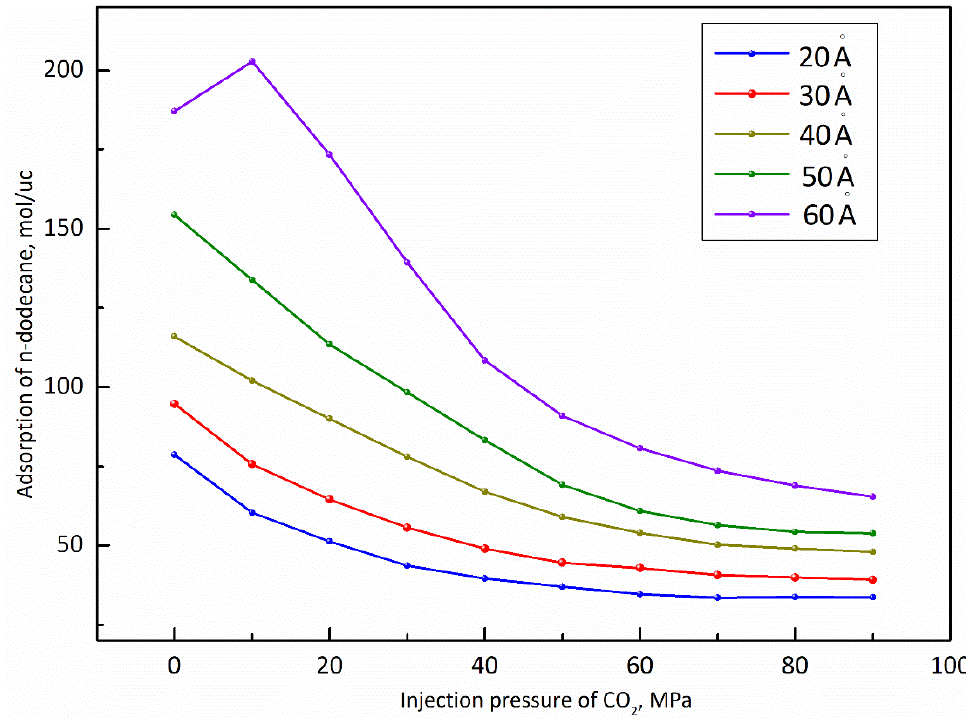
Figure 5. The molar quantity of n-dodecane absorbed in the pores of different sizes under different injection pressure of CO 2.